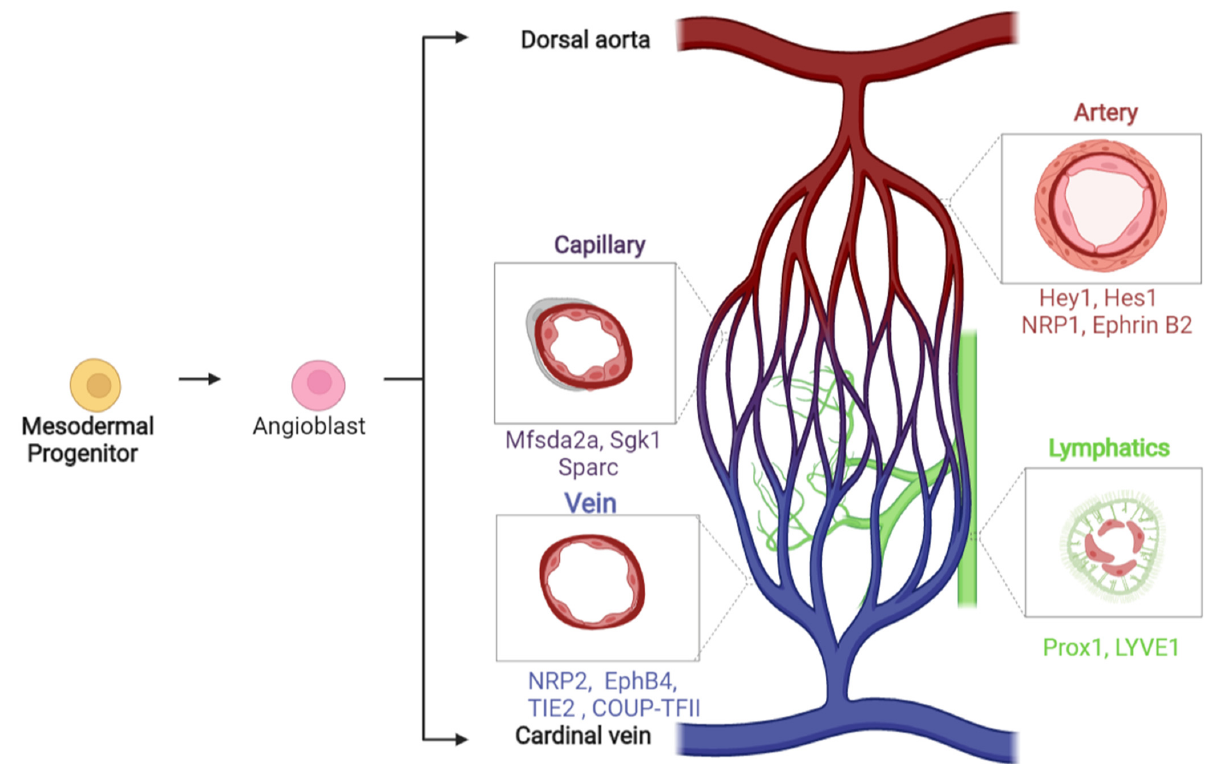
Figure 1. Schematic illustrating the major markers of endothelial diversity generated throughout vascular development, as mesodermal progenitors give rise to angioblasts that ultimately differentiate into endothelial cells with specific arterial, venous, lymphatic and capillary identities. Understanding of these developmental markers and mechanisms has built up from decades of fundamental research using avian, rodent, fish and human tissue culture models [8,17–24]. Image pro- duced in BioRender. The establishment of individual vessels highlights that endothelial cell heterogeneity extends beyond different organs. For example, the structure of the endothelium for vari- ous types of networks varies enormously: arteries and veins comprise an uninterrupted, continuous layer of cells, while capillaries have a variety of tissue-dependent organisa- tional options, including discontinuous and fenestrated arrangements. This structural het- erogeneity is mirrored in gene expression, with experiments performed on different mam- malian arteries showing distinct genetic profiles to each other [37]. Endothelial cell heter- ogeneity can be seen in different vessels within the same tissue and even adjacent endo- thelial cells within the same vessel [38]. Studies have revealed the importance of interac- tions between Notch and VEGF signalling pathways in defining tip cell and stalk cell iden- tities. Endothelial cells are initially induced to sprout from the DA via VEGF signalling, stimulating Notch signalling in these newly determined tip cells, thus in turn suppressing VEGF signalling in the trailing stalk cells [39–42]. Although VEGF signalling is indeed implicated as the most crucial signalling input for endothelial cells, additional factors are also important in regulating key endothelial cell functions and behaviours. For example, genetic expression studies revealed how certain genes—such as transmembrane 4 L six family membrane 18 (tm4sf18)—are restricted to these actively sprouting endothelial cells, and function as amplifiers of VEGF signalling for specific subsets of endothelial cells, to fine-tune vessel formation [43]. Calcium (Ca 2+ ) oscillations have also been shown to corre- late with specific endothelial cell behaviours, with maintenance of Ca 2+ activity restricted only in sprouting tip cells in both zebrafish and in mammalian tissue culture [44,45]. Fur- ther examples of heterogeneity mechanisms are seen in live imaging of endothelial cell